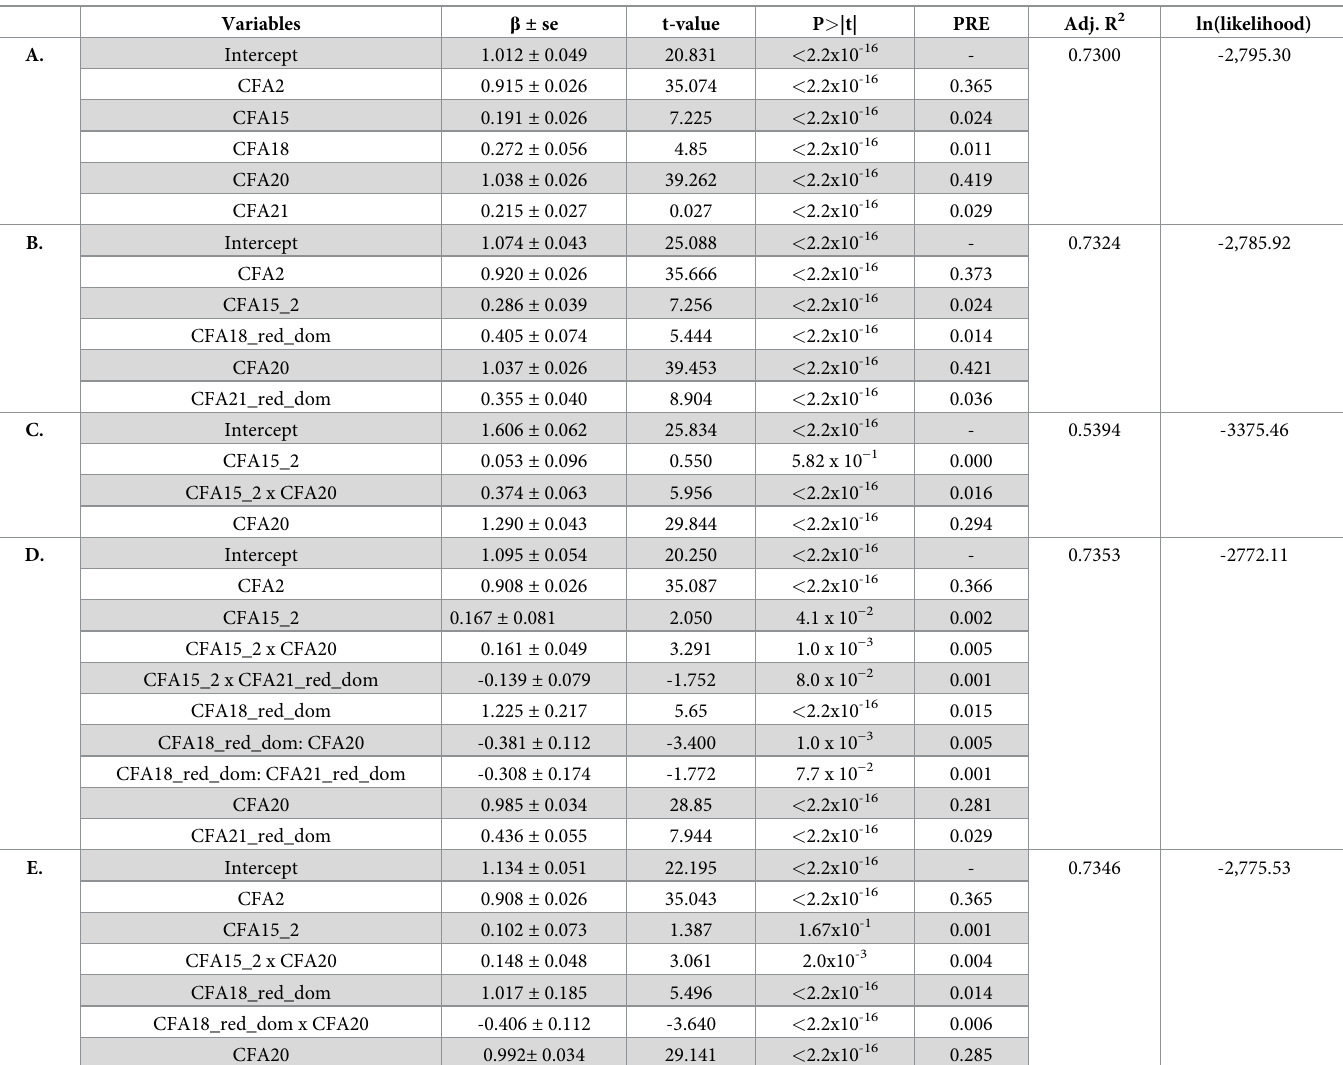
Table 5. Comparison of multilocus coat pheomelanin intensity predictive